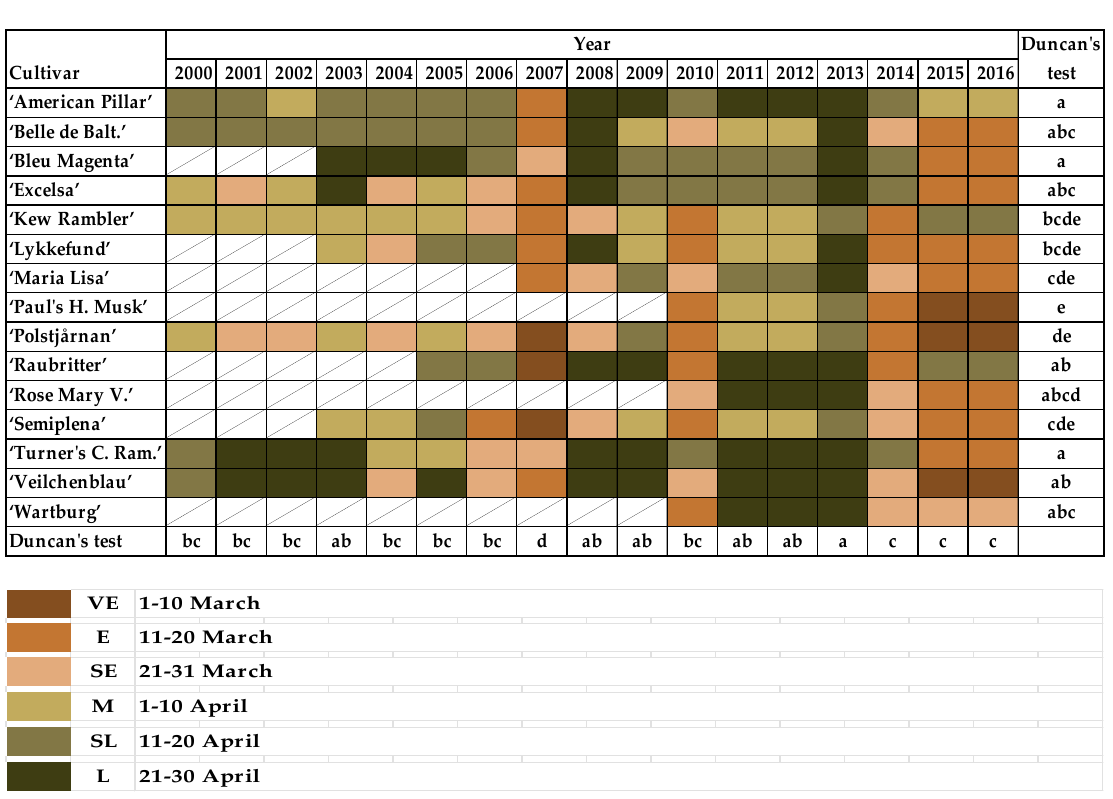
Figure 6. Periods when the buds on unpruned shoots are at the beginning of breaking and the first green leaf tips are visible (BBCH 07) in rambler roses. Different letters indicate significant differences between cultivars and years. The Duncan’s test ( α = 0.05) was used.